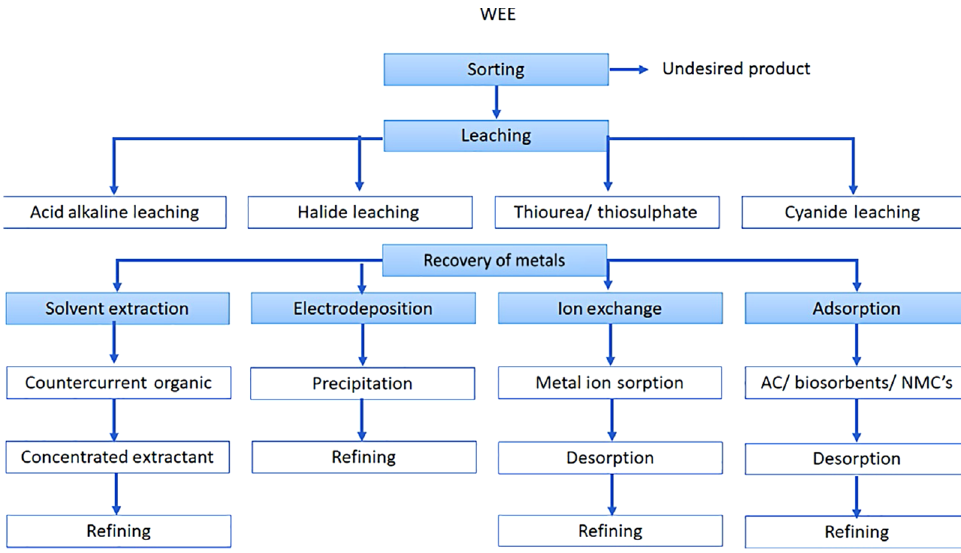
Figure 7. The detailed flowchart for hydrometallurgical processes utilized for the recovery of waste electric/electronic equipment (WEE) [51].